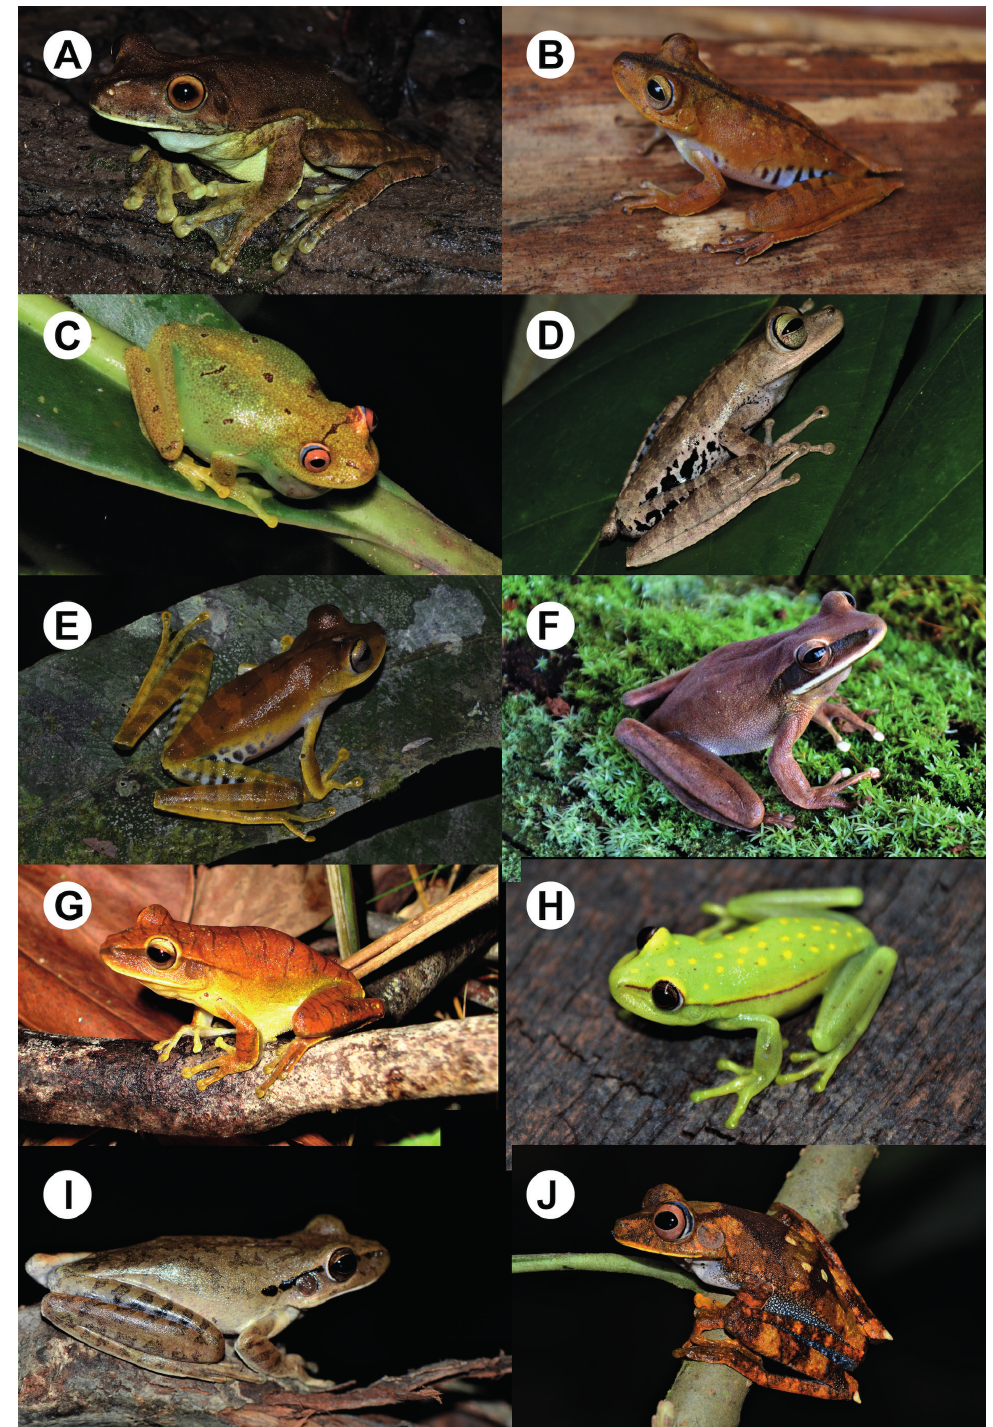
Fig. 2. Anuran species recorded in the state of Amapá. A . Boana boans (Linnaeus, 1758). B .